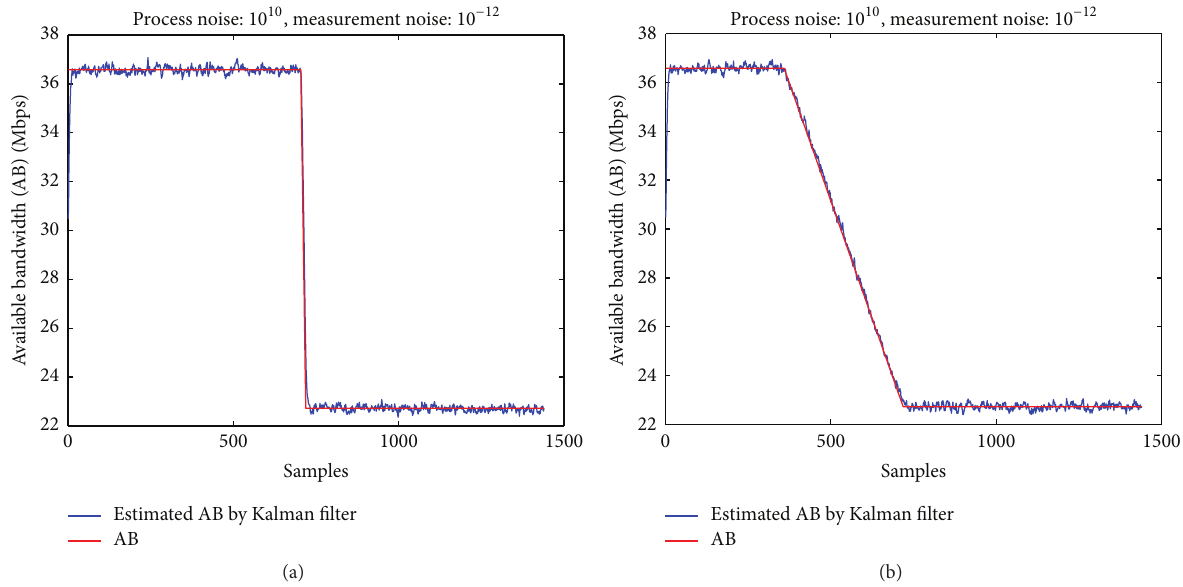
Figure 1: The AB estimated by DEKF against the actual AB value for (a) an abrupt AB variation and (b) a slower variation.